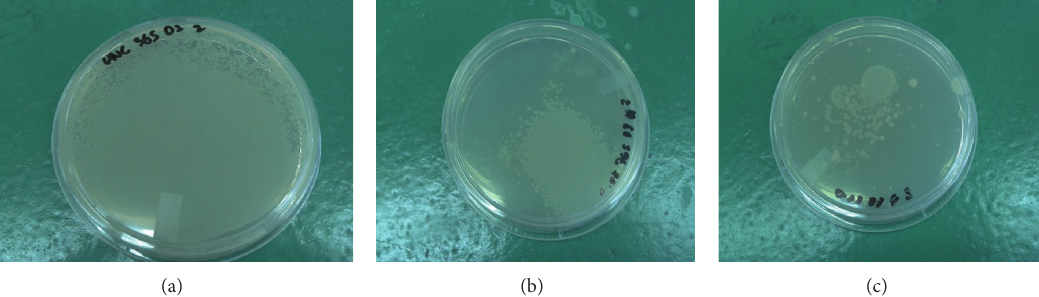
Figure 2: E. coli colony on agar plate for lettuce packed inside (a) uncoated (b) 0.05 g TiO 2 /100mL MEK and (c) 0.08 g TiO 2 /100 mL MEK coated films after three days of UV light illumination.